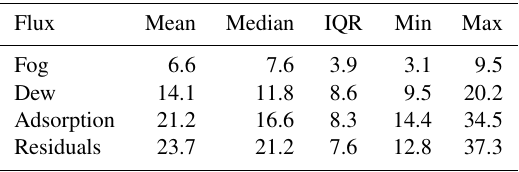
Table 1. Mean, median, and interquartile range (IQR) and mini- mum and maximum annual sum of individual NRW fluxes across lysimeter columns. All values are reported in millimeters per year (mmyr − 1